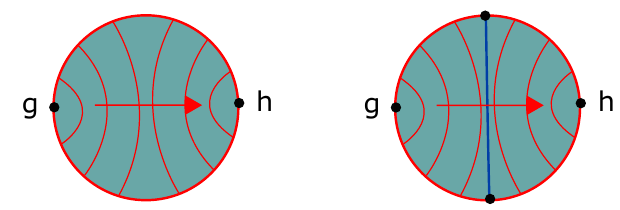
Figure 5 . Left: Hilbert space slicing in the point-defect channel, representing propagation between pointlike defects. Right: amplitude with a Wilson line inserted.